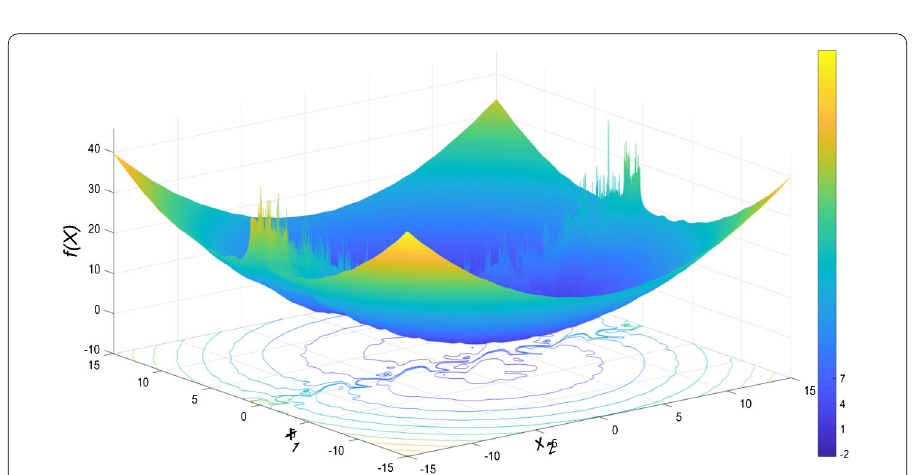
Figure 2 Three-dimensional view of Mishra 6